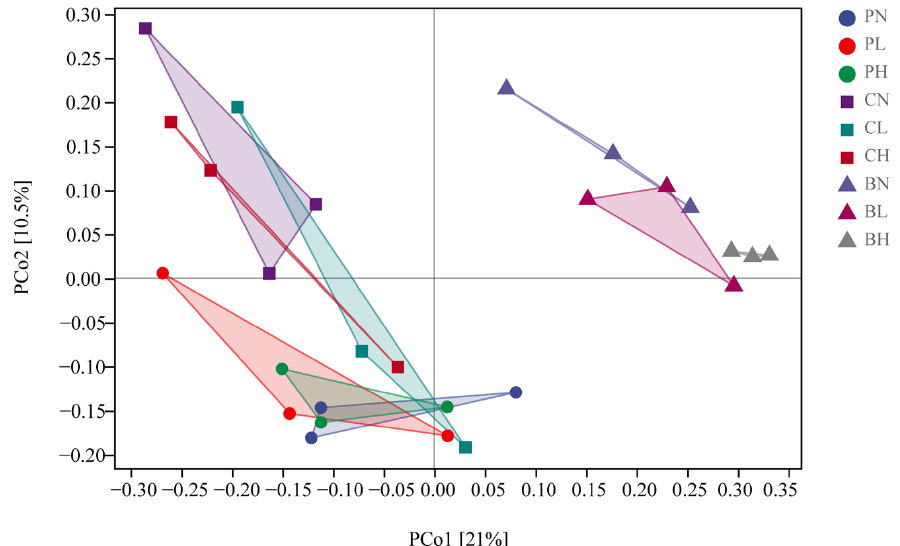
Figure 2. Principal coordinate analysis (PCoA) of bacterial ASV Bray–Curtis distances for different treatment. P, C, and B represent hydroxyapatite addition, no amendments, and biochar addition, respectively. L, N, and H represent low planting density, no planting, and high planting density, respectively.